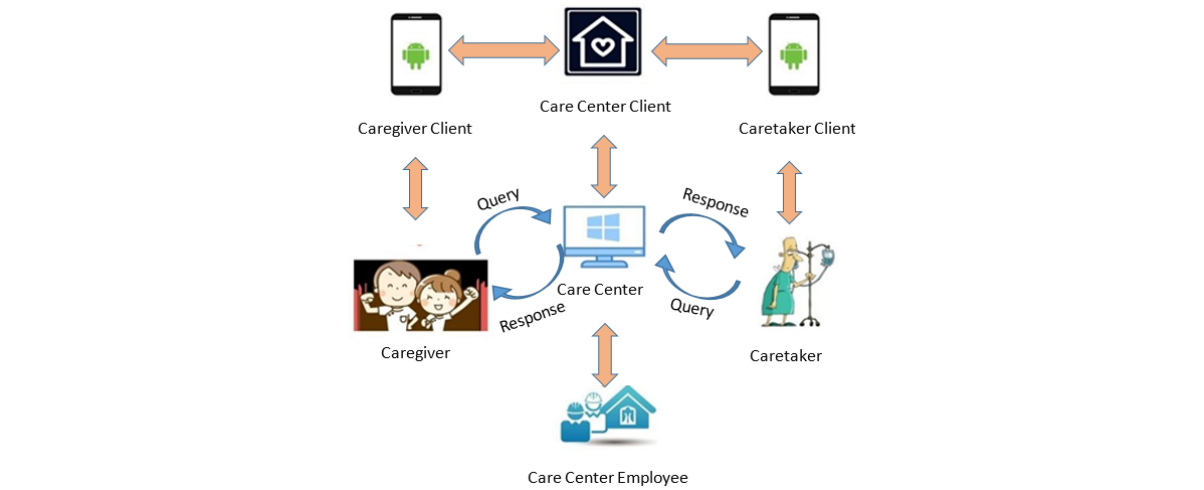
Figure 1. Overview of the current matching